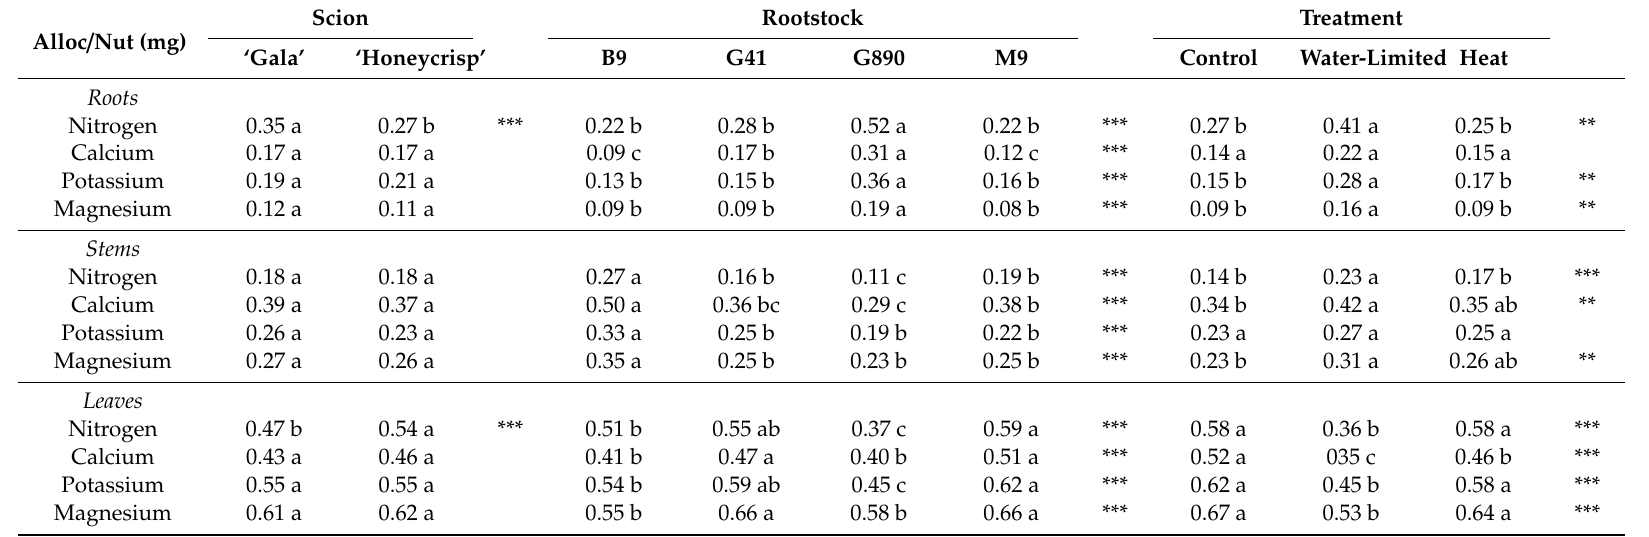
Table 4. Nitrogen, calcium, potassium and magnesium partitioning among roots, stems and leaves of ‘Gala’ and ‘Honeycrisp’ apple scion genotypes in combination with B9, G41, G890, and M9 rootstocks genotype under untreated control, water-limited, or elevated soil temperature treatments. Di ff erent letters denote significant di ff erences among columns determined using a Tukey’s mean separation test ( α = 0.05). ***, ** and * indicate significance in di ff erences among means at p -values < 0.0001, < 0.01 and < 0.05,